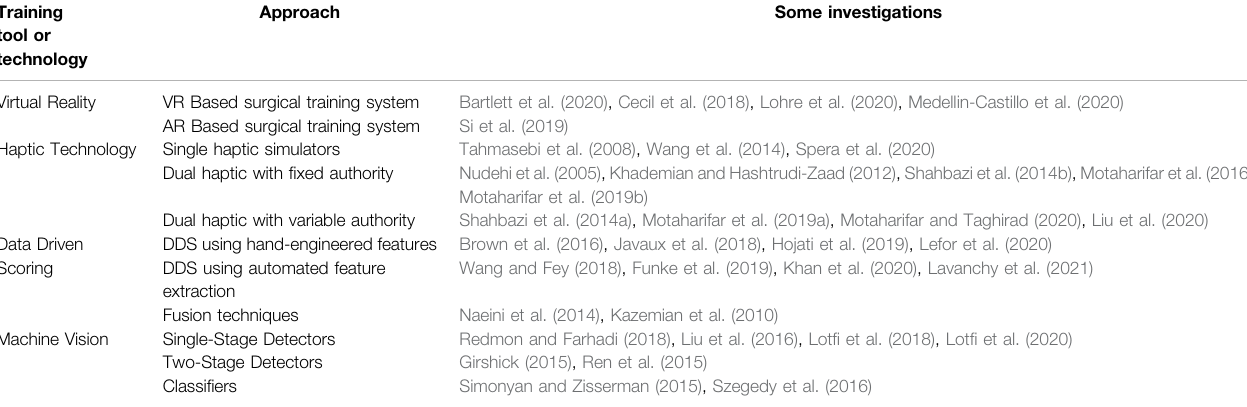
TABLE 2 | The main tools and approaches that help to reduce physical contact in medical training. Training tool